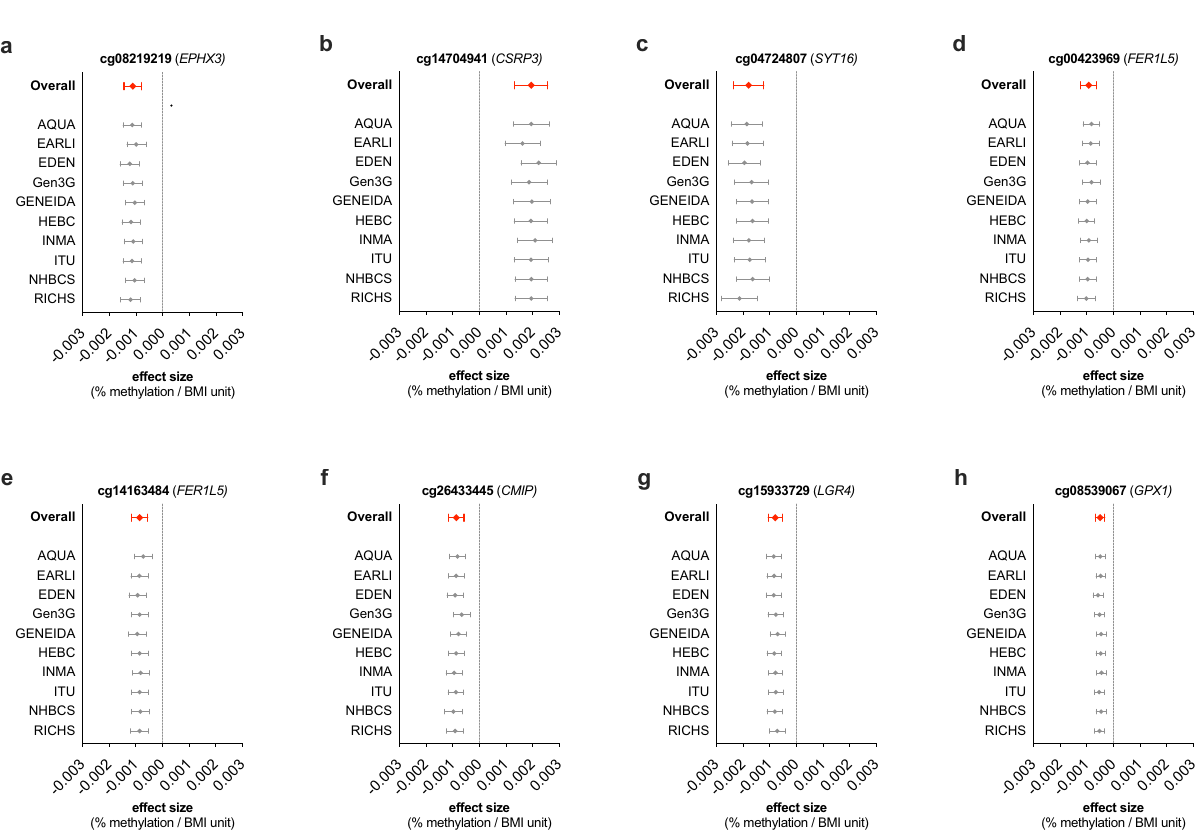
Fig. 3 Forest plots of the leave-one-out analysis showing the fi xed effects meta-analysis estimates of association between maternal ppBMI and placental DNAm. Association of a cg08219219, b cg14704941, c cg04724807, d cg00423969, e cg14163484, f cg26433445, g cg15933729, h and cg08539067 with maternal ppBMI. In all panels, cohort names indicate the cohort excluded in each row, and error bars represent the 95% con fi dence interval of the effect size. Numerical source data for the fi gure are available in fi le Supplementary Data